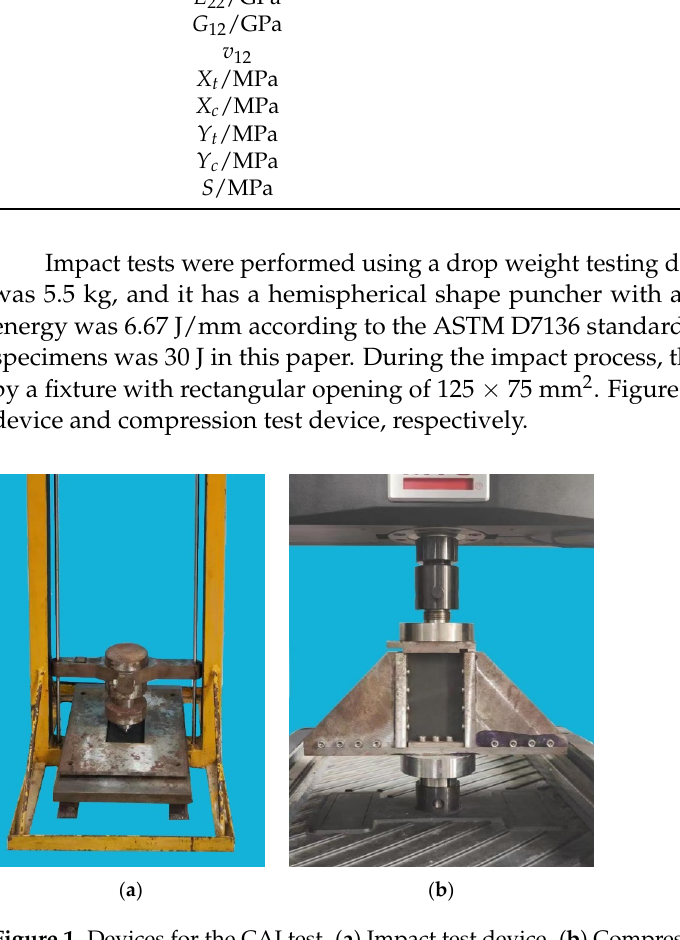
( c ) Figure 2. Damage of specimens after impact. ( a ) Upper surface. ( b ) Lower surface. ( c ) Image of C ‐ scan.